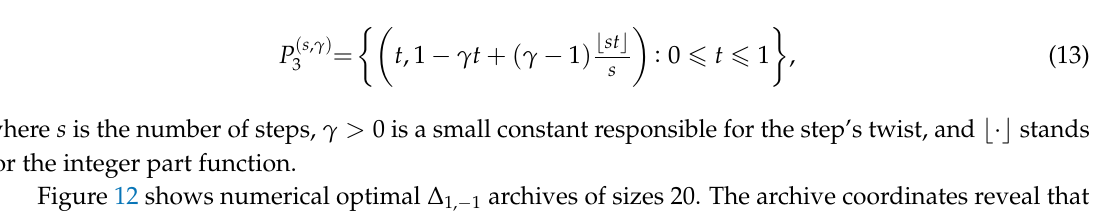
Figure 12. Numerical optimal ∆ 1, − 1 archive A for the disconnect step Pareto front P Equation (13) with 20 elements: here, we obtain ∆ 1, − 1